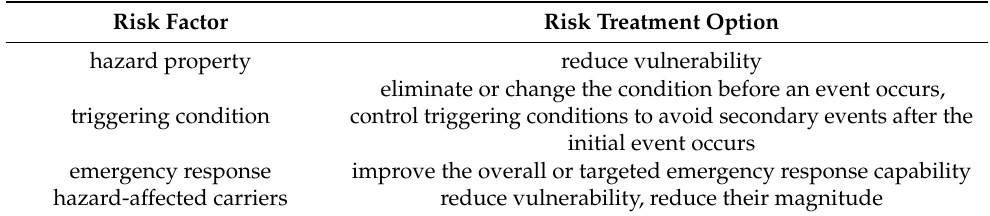
Table 1. Risk treatment options for oil pipeline accidents.